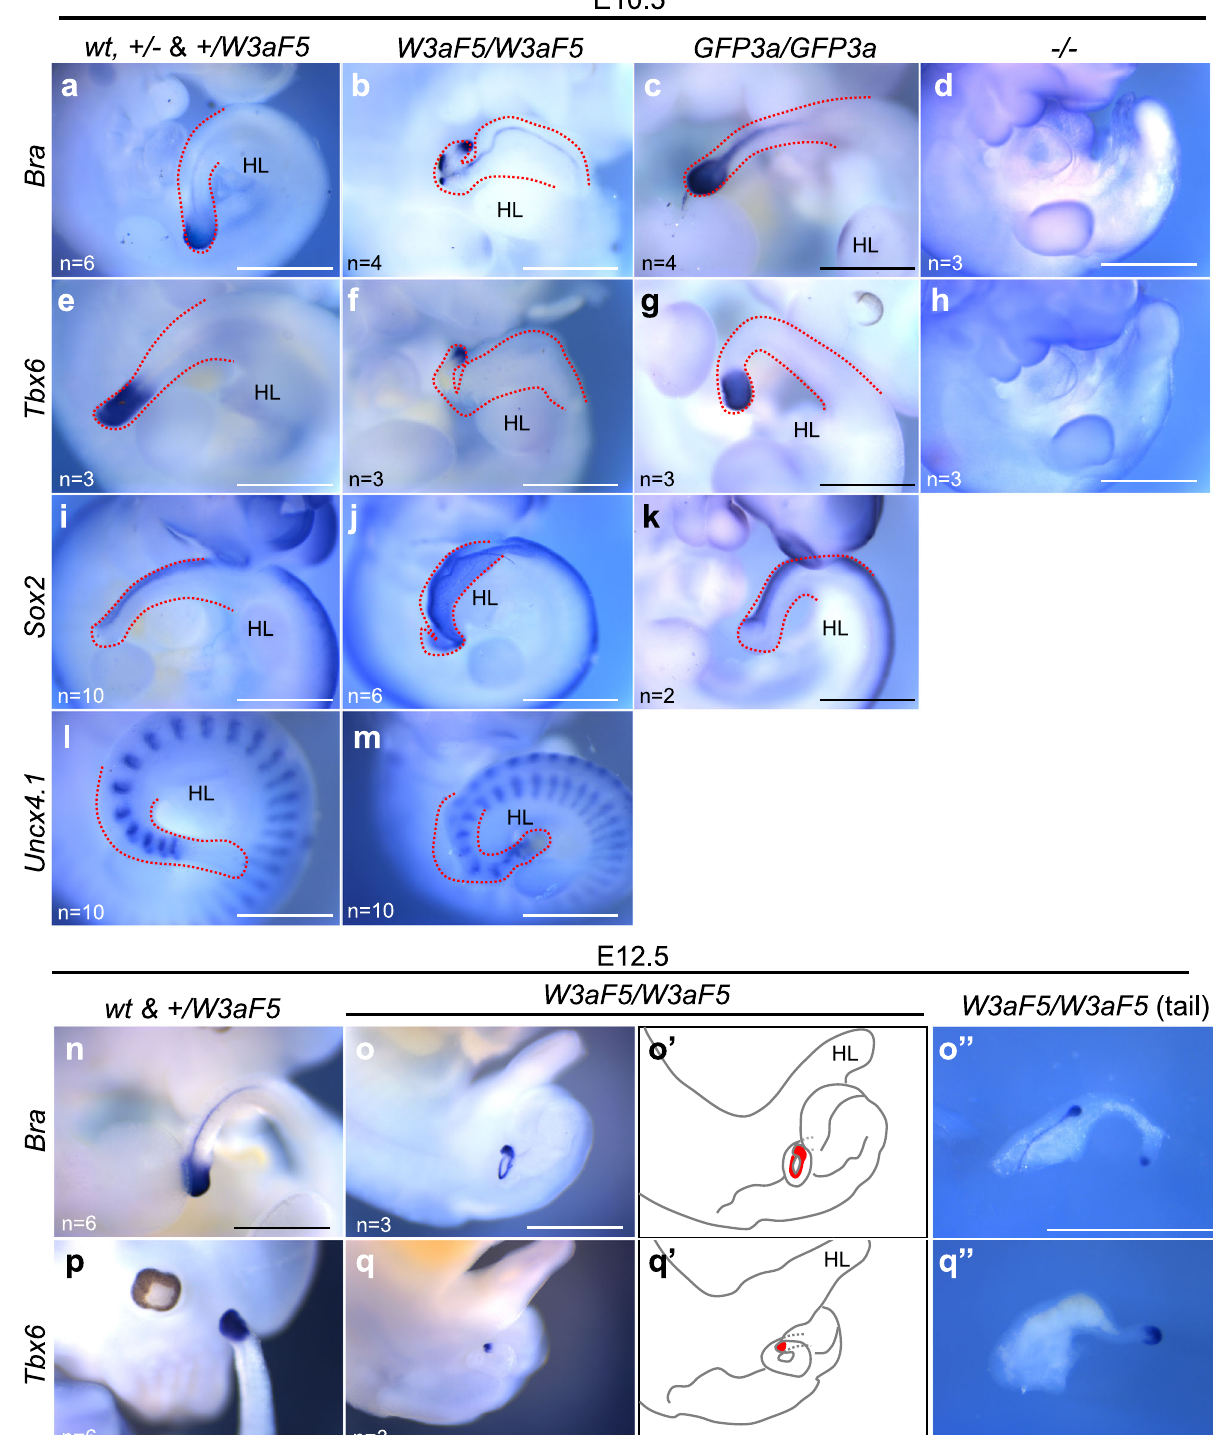
Fig. 2 | Expression of mesoderm and neural marker genes in Wnt3a-Fzd5 homozygous embryos. a – m Expression of mesodermand neural marker genesin embryos at E10.5. Whole-mount in situ hybridization was carried out using probes of Bra ( a – d ), Tbx6 ( e – h ), Sox2 ( i – k ),and Uncx4.1 ( l , m )in wt,Wnt3a +/ − , & Wnt3a +/Fzd5 ( a , e , i , l ), Wnt3a Fzd5/Fzd5 ( b , f , j , m ), Wnt3a GFP3a/GFP3a ( c , g , k ), and Wnt3a − / − ( d , h ) embryos at E10.5. Red dotted lines indicate tail regions. n – q Expression of